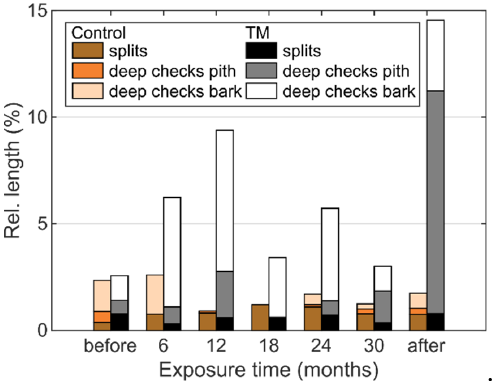
Figure 7. Mean relative length of splits and deep checks (% of total board length) from visual assessment of ‘exposed’ control and TM boards by exposure time.